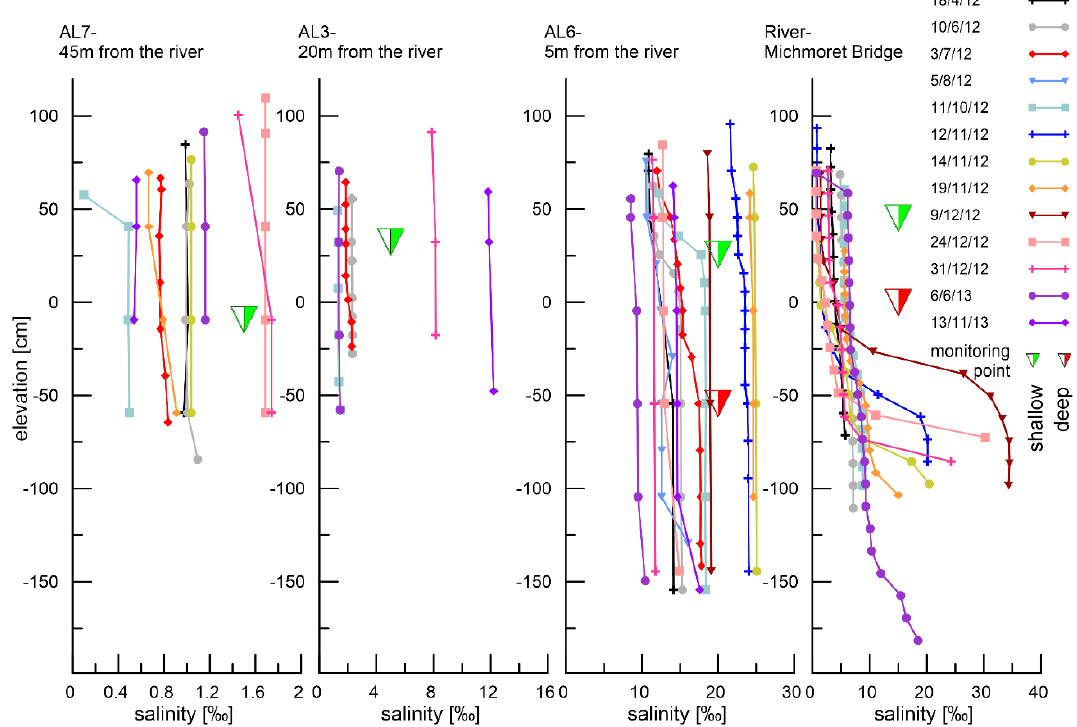
ff erences in the salinity